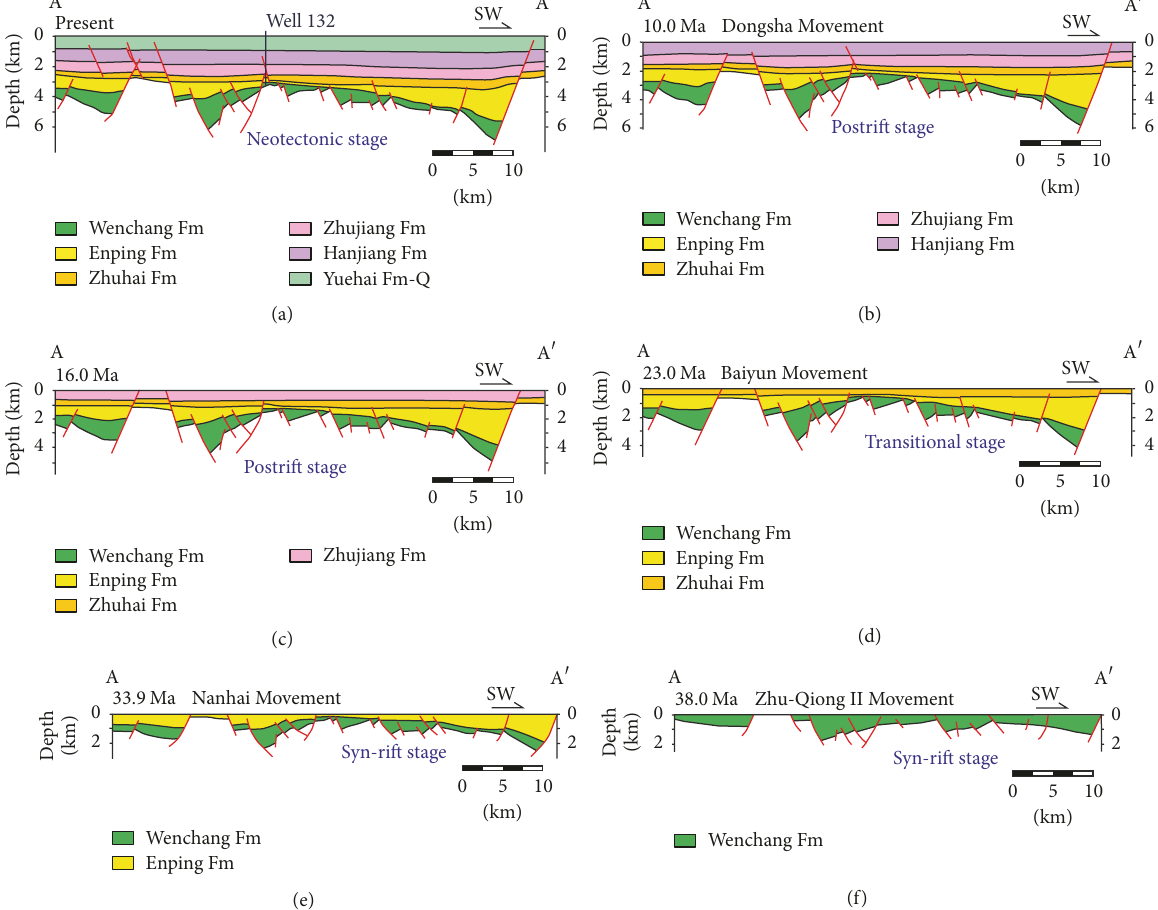
is shown in Figure 1).